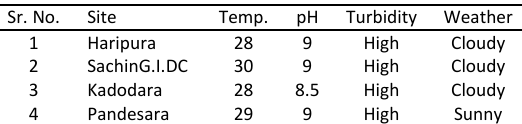
Table: 1 Characteristics of sample and collection site Table. 1 Characteristics of sample and collection site